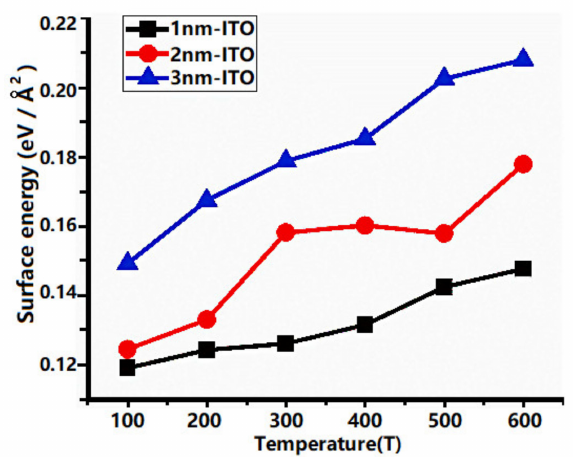
Figure 5. Surface energy of 1, 2, and 3 nm ITO models at temperatures ranging from 100 to 600